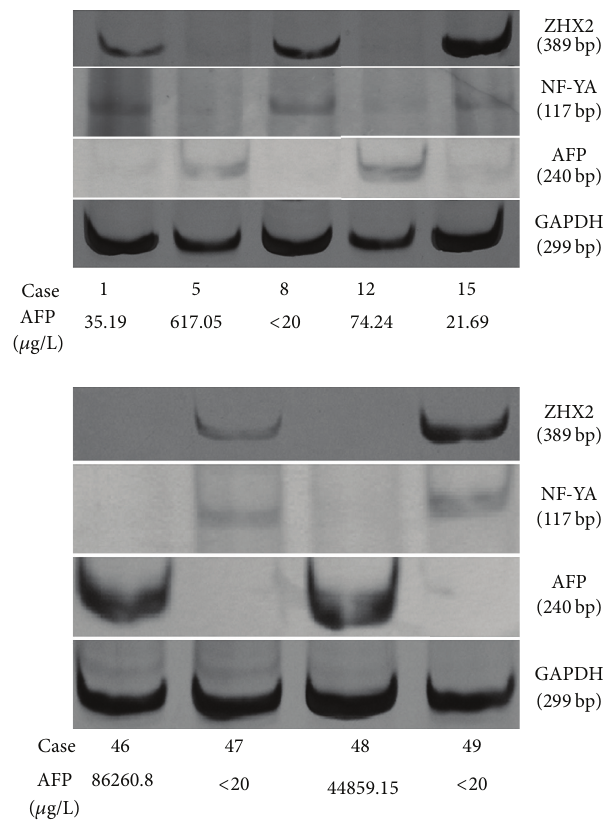
Figure 1: expression of zinc fingers and homeoboxes 2 (ZHX2), nuclear factor-YA (NF-YA), and alpha-fetal protein (AFP) mRNA in hepatocellular carcinoma (HCC) tissues. The target mRNA expression was detected by RT-PCR analysis. The expression of glyceraldehyde-3-phosphate dehydrogenase (GAPDH) served as an internal control. In cases 1, 8, 15, 47, and 49, ZHX2 and NF- YA mRNAs were detected, but AFP mRNA expression was not observed. In cases 5, 12, 46, and 48, ZHX2 and NF-YA mRNAs were not detected, but AFP mRNA expression was observed.